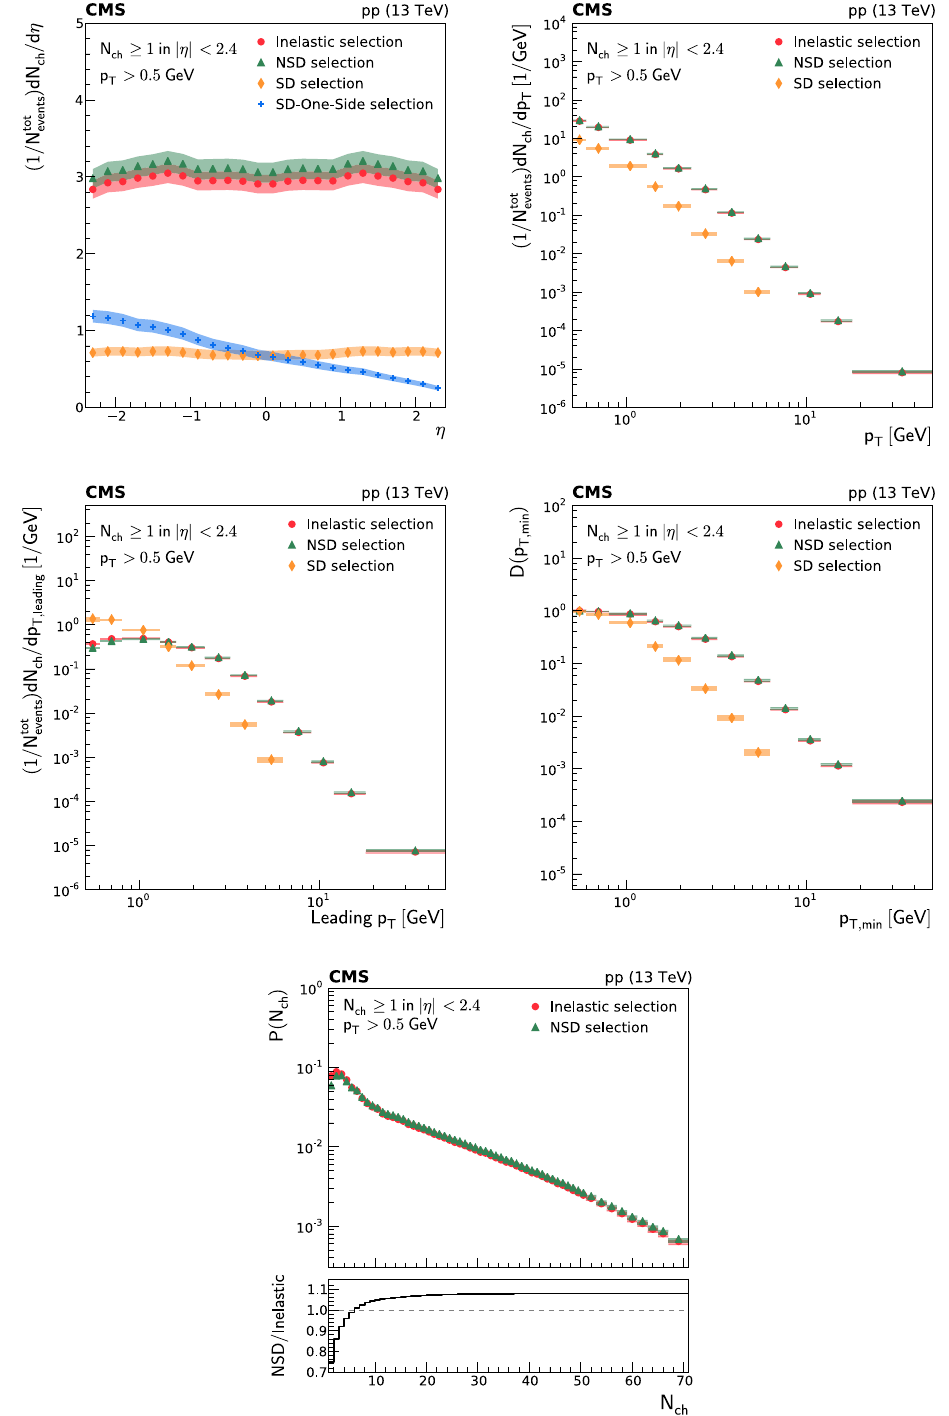
Fig. 1 From top to bottom, left to right: pseudorapidity , p T , leading p T ,integratedleading p T ,andmultiplicityofchargedparticlesperevent fortheinelastic(circles),NSD-enhanced(triangles),SD-enhanced(dia- monds), and SD-One-Side enhanced (crosses) event samples. The band